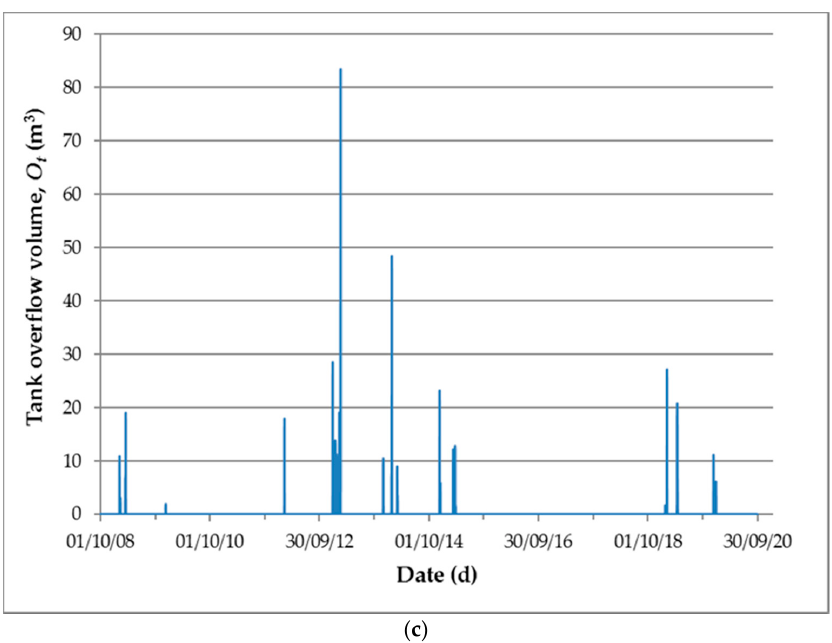
Figure 5. Stored water volume in the tank ( a ); cumulative water volume supplied from other sources to meet the water needs of begonia crop ( b ); and overflow water volume from the tank ( c ) as computed by applying the daily water balance method for tank size V tank = 100 m 3 and collection area A = 1000 m 2 .